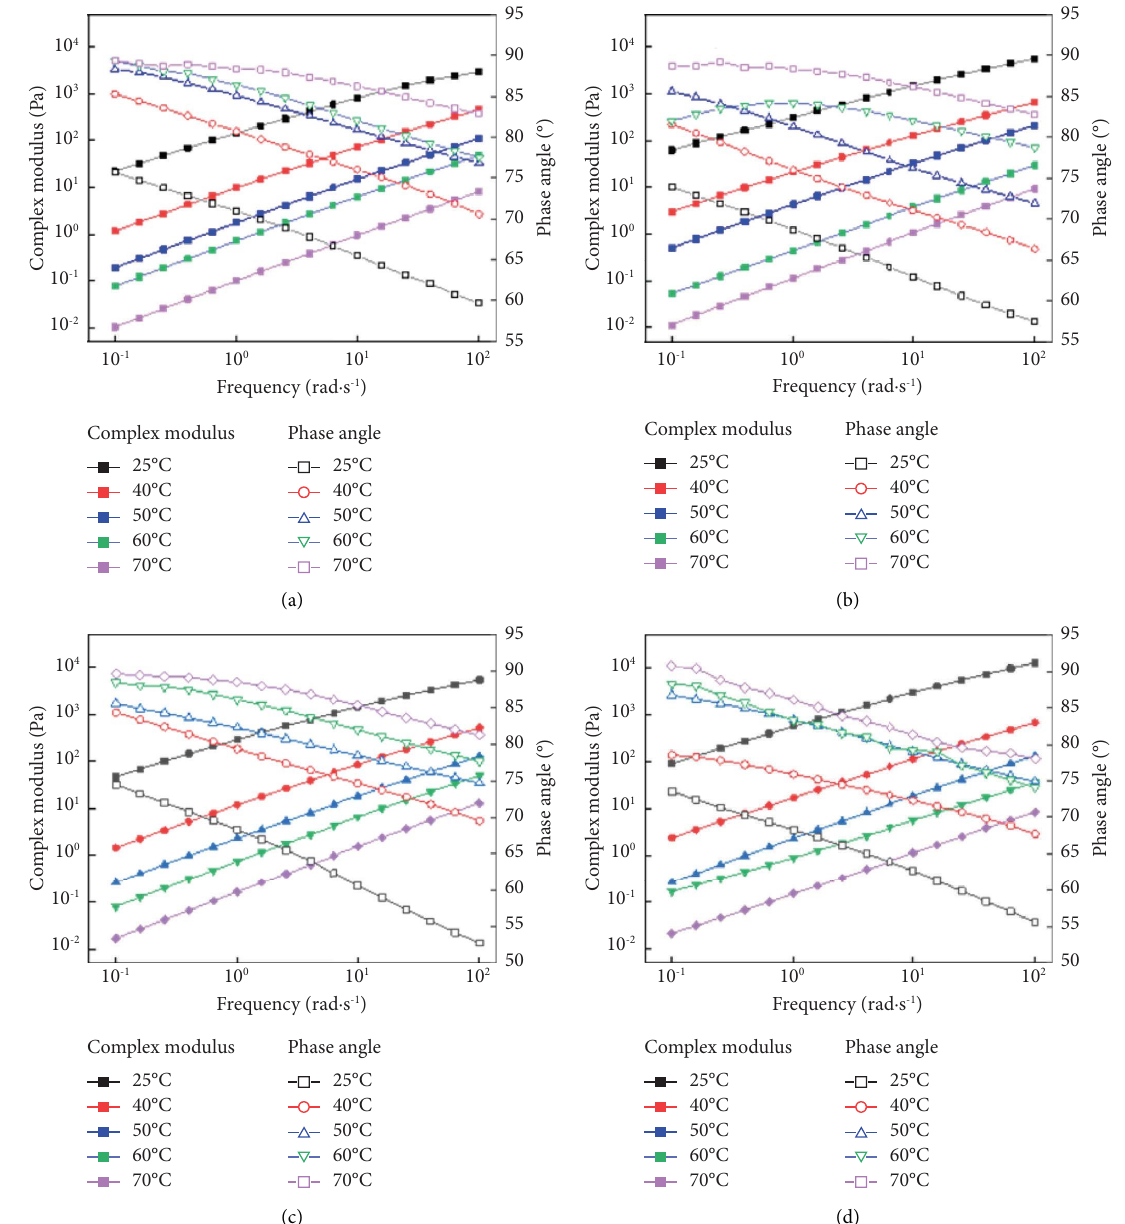
Figure 4: G ∗ and δ change curves of T622 modifed asphalt under different aging times. (a) 76.25h. (b) 152.5h. (c) 228h. (d)